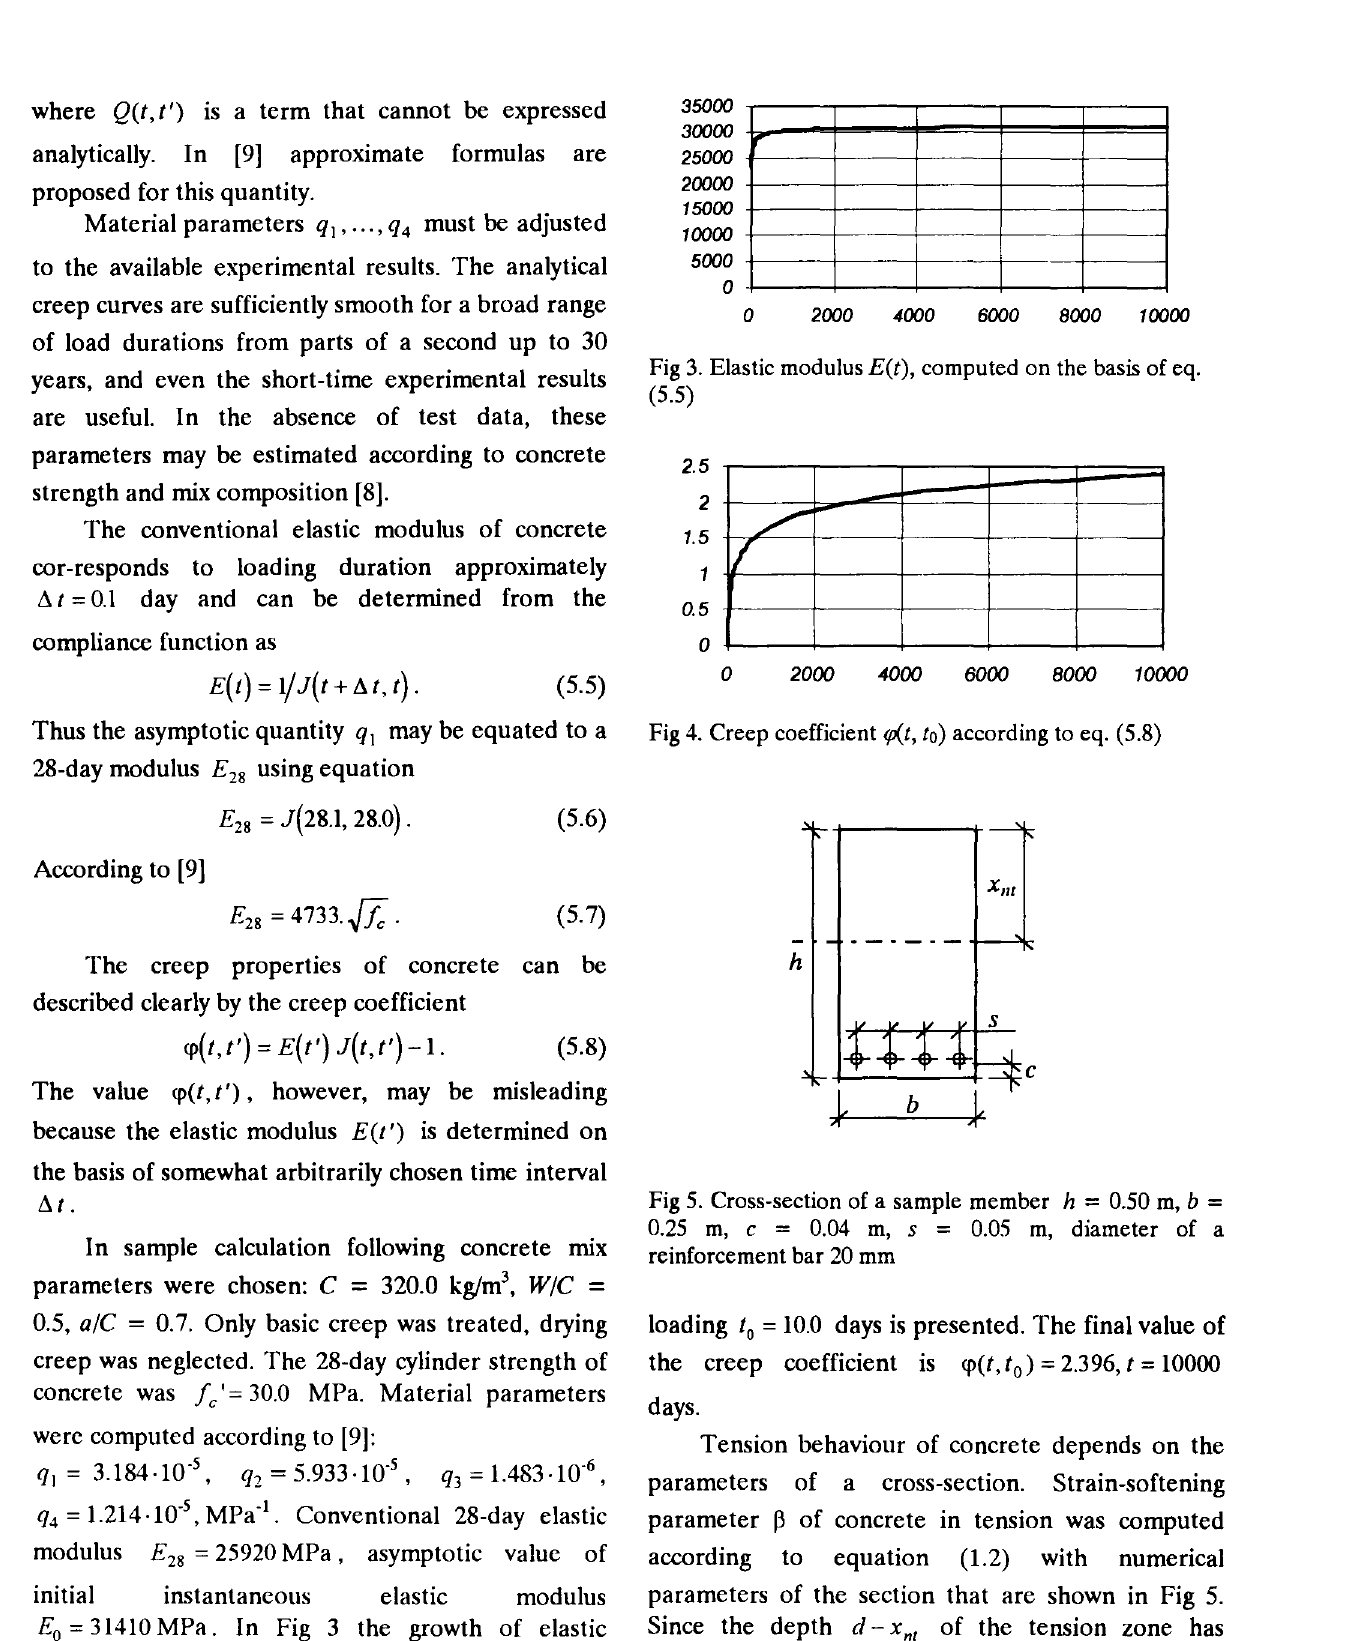
Fig 3. Elastic modulus E(t), computed on the basis of eq.